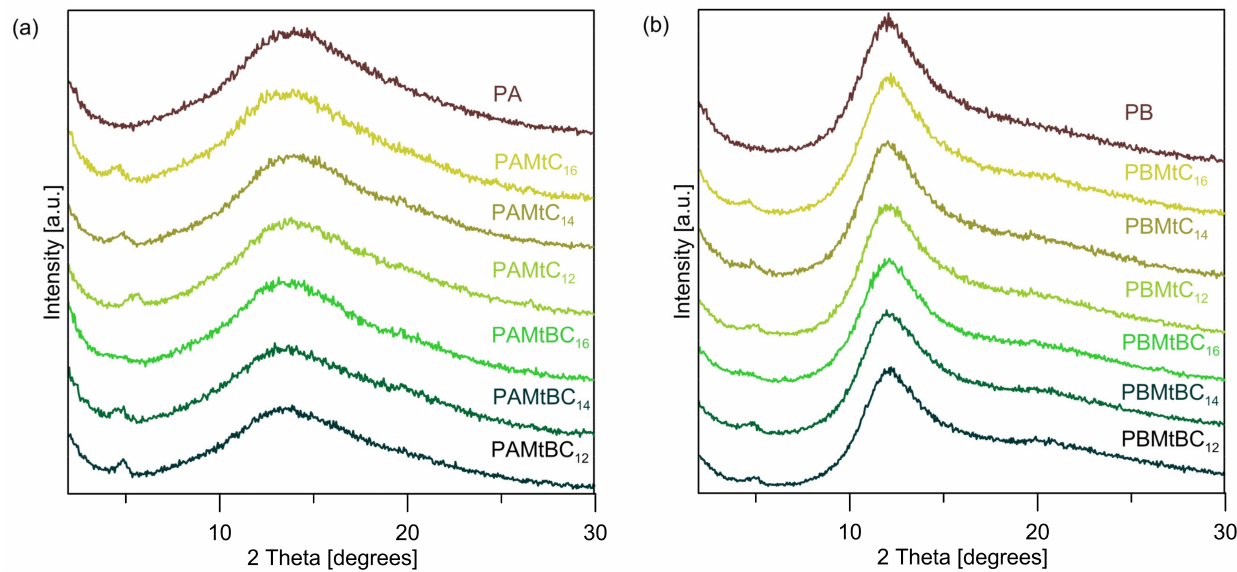
Figure 7. XRD patterns of the initial networks and clay mineral–polysiloxane nanocomposites: ( a ) PA series and ( b ) PB